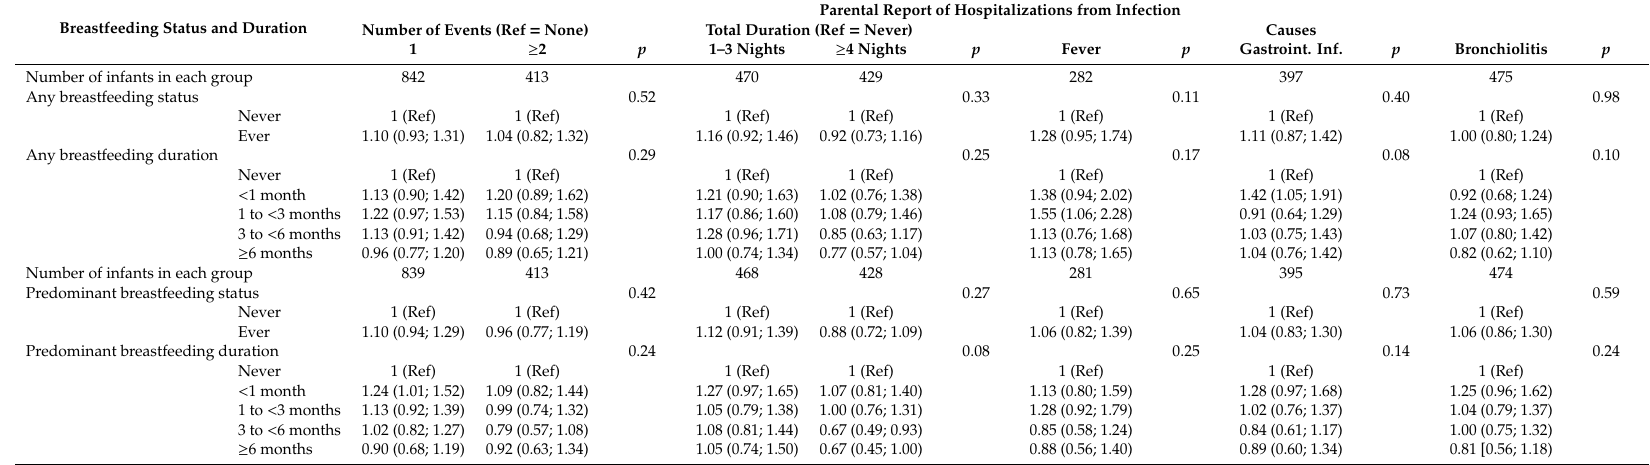
Table 2. Association between breastfeeding and parent reports of hospitalizations from infection: multivariate analyses ( n = 10,349). Breastfeeding Status and